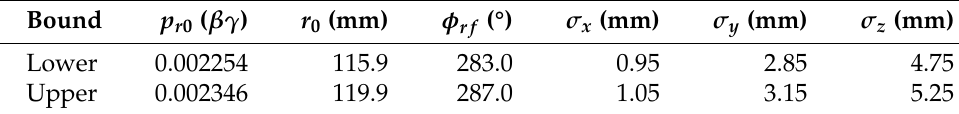
Table A4. The design variables and their ranges for the IsoDAR accelerator